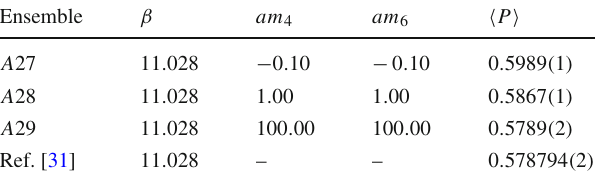
Table 2 Benchmark comparison of the value of the average plaquette in the infinitely-heavy-fermion limit to the quenched results for SU ( 4 ) from Ref.